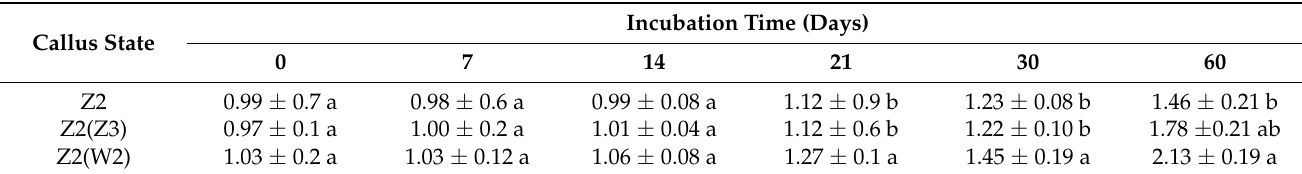
Table 2. Changes in the fresh weight of F. mandshurica embryogenic callus in different states with culture